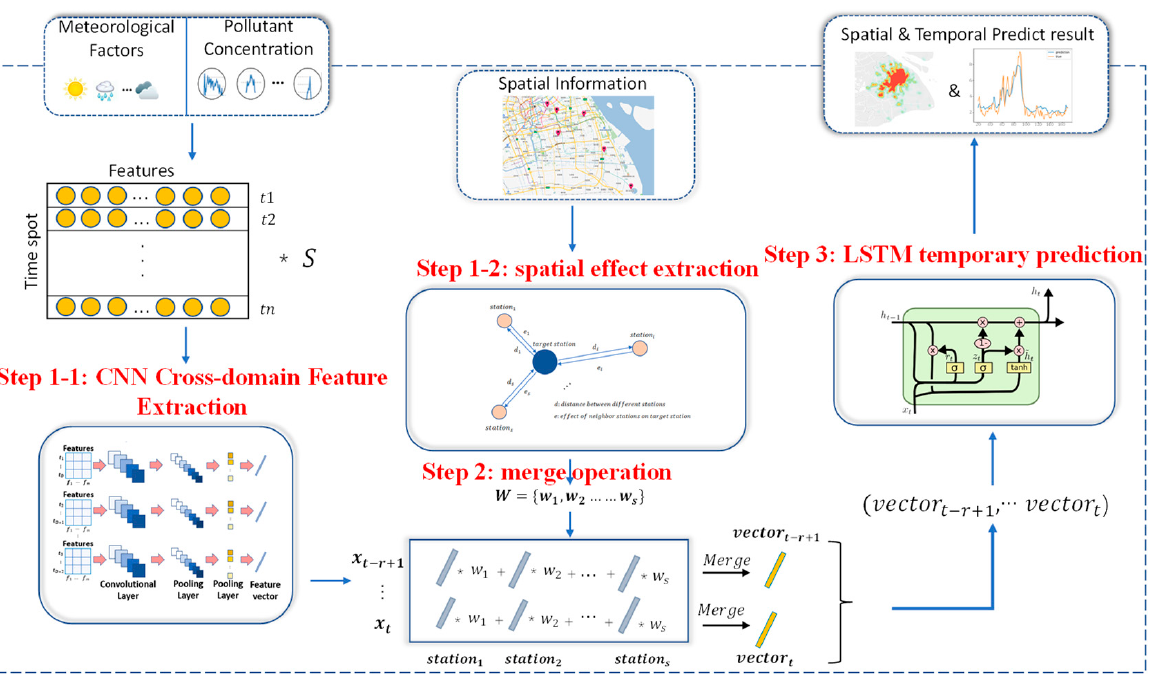
Figure 2. Architecture overview of the HDL-learning framework.